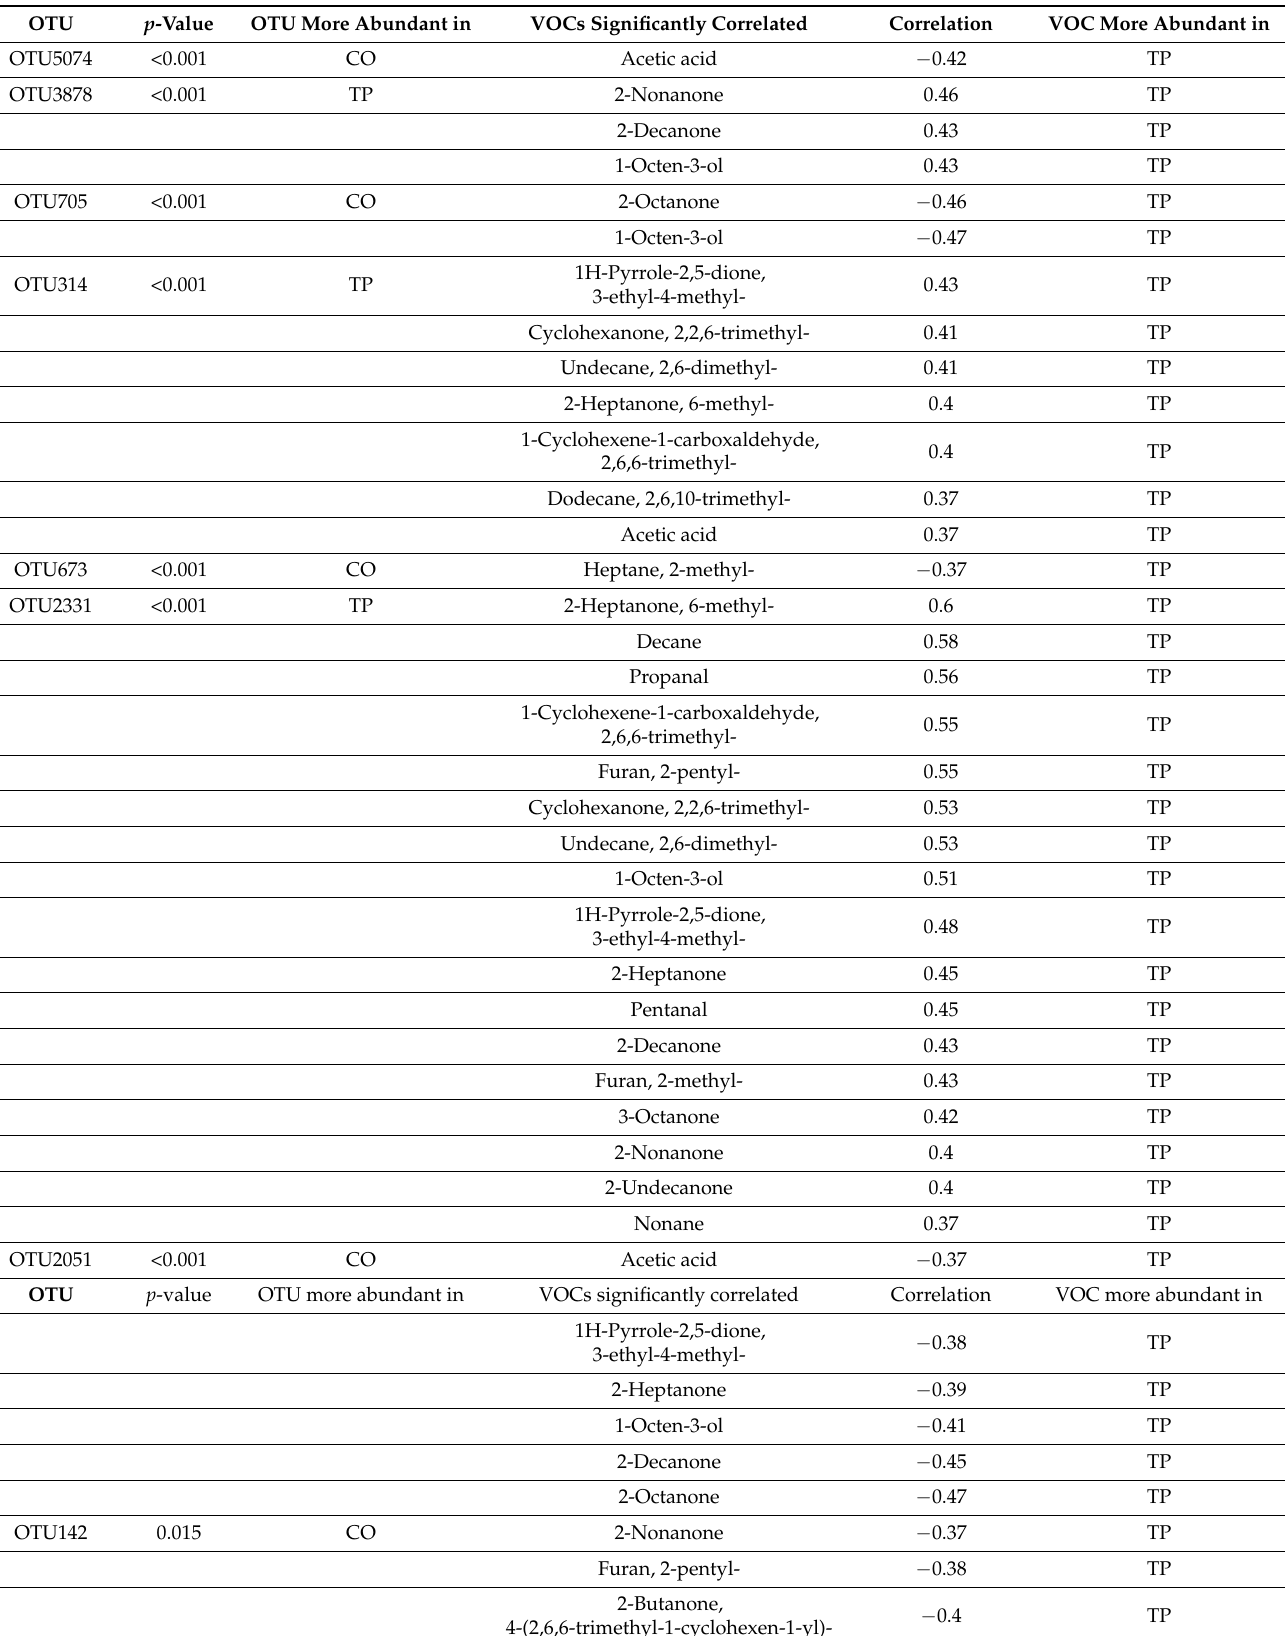
Table 3. Operational taxonomic units (OTUs) and volatile organic compounds (VOCs) identified in single omics analysis that were significantly correlated with each other when